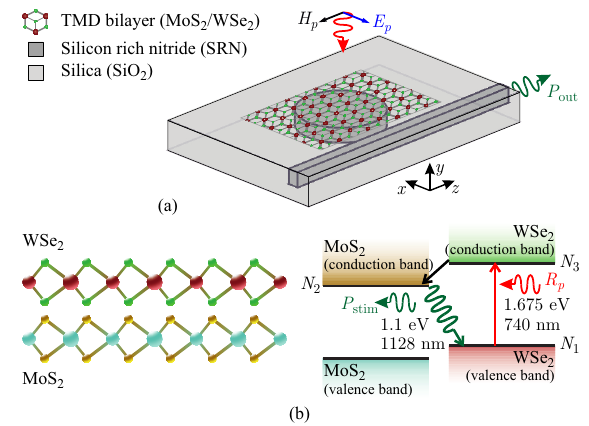
Figure 1. (a) Schematic of the proposed whispering-gallery mode cavity (disk resonator) with the TMD heterobilayer on-top. The vertical pump illumination and the output channel are both clearly marked. (b) Atomic structure of the WSe 2 , MoS 2 mono- layers and the three-level energy diagram of the heterostructure, which allows for stimulated emission around 1128 nm due to the interlayer excitons formed between MoS 2 conduction and WSe 2 valence bands.